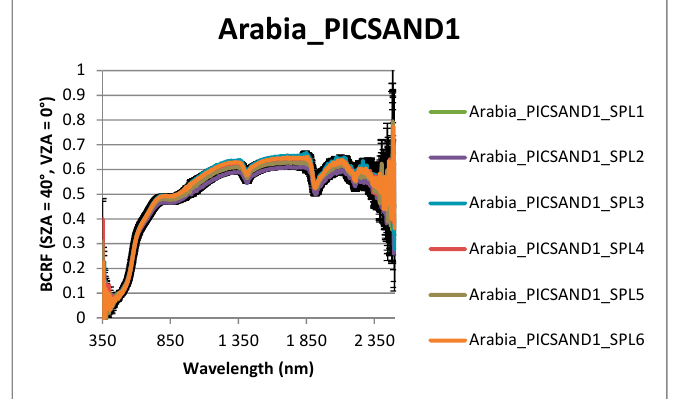
Figure 6. Arabia_PICSAND1 BCRF discrepancy between samples compared to one measurement